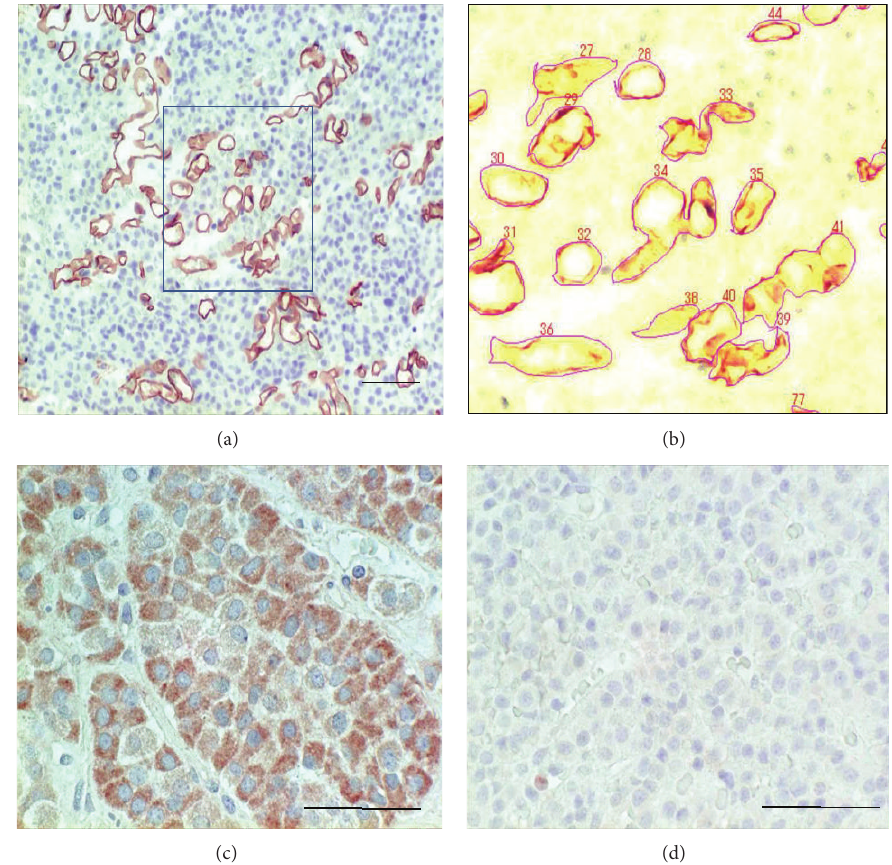
Figure 1: Determination of microvascular density and vascular architecture (a, b) and VEGF immunohistochemistry (c, d). CD34-stained fields (1.0mm 2 ) (a) are input into the image analyzer, and each vessel contour is manually traced in order to measure vessel density (number), vessel area (%), vessel diameter ( 𝜇 m), vessel perimeter ( 𝜇 m), and vessel roundness (0-1) (b). The area of the black box in (a) is magnified to (b). VEGF immunohistochemistry: positive tumor with clear cytoplasmic staining (c) and negative tumor (d). Original magnification (a): 200x, (c), (d): 400x. Bar 100 𝜇